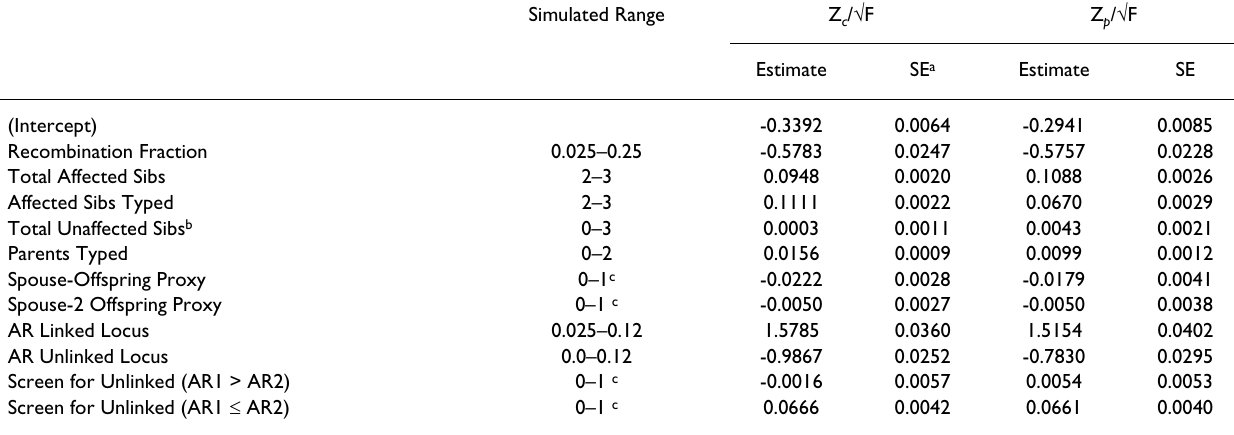
Table 5: Effect of design and population parameters or non-centrality parameters